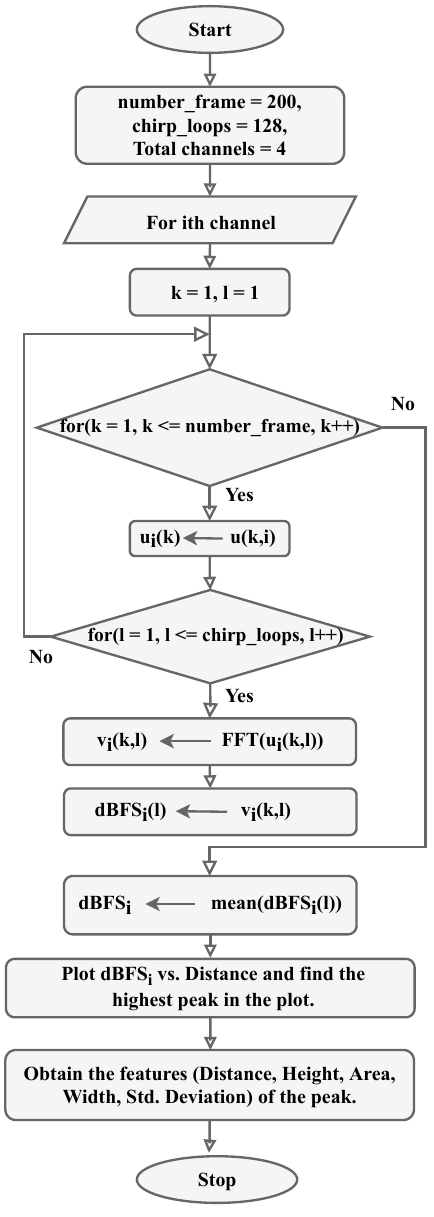
Figure 5. Features extraction flow